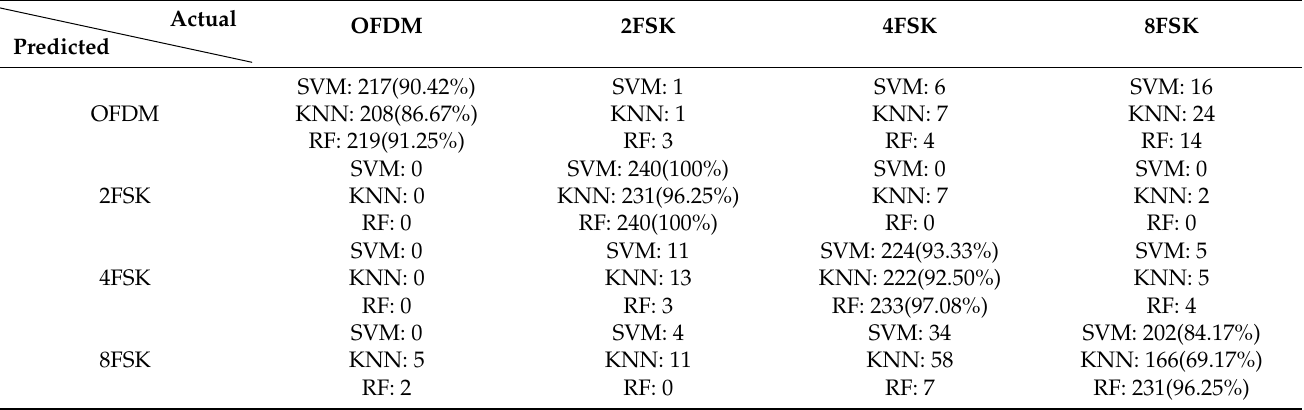
Figure 14. Experimental environment. ( a ) Experimental diagram, ( b ) data acquisition equipment, and ( c ) measured CIR. Table 4. Classification results of the experimental